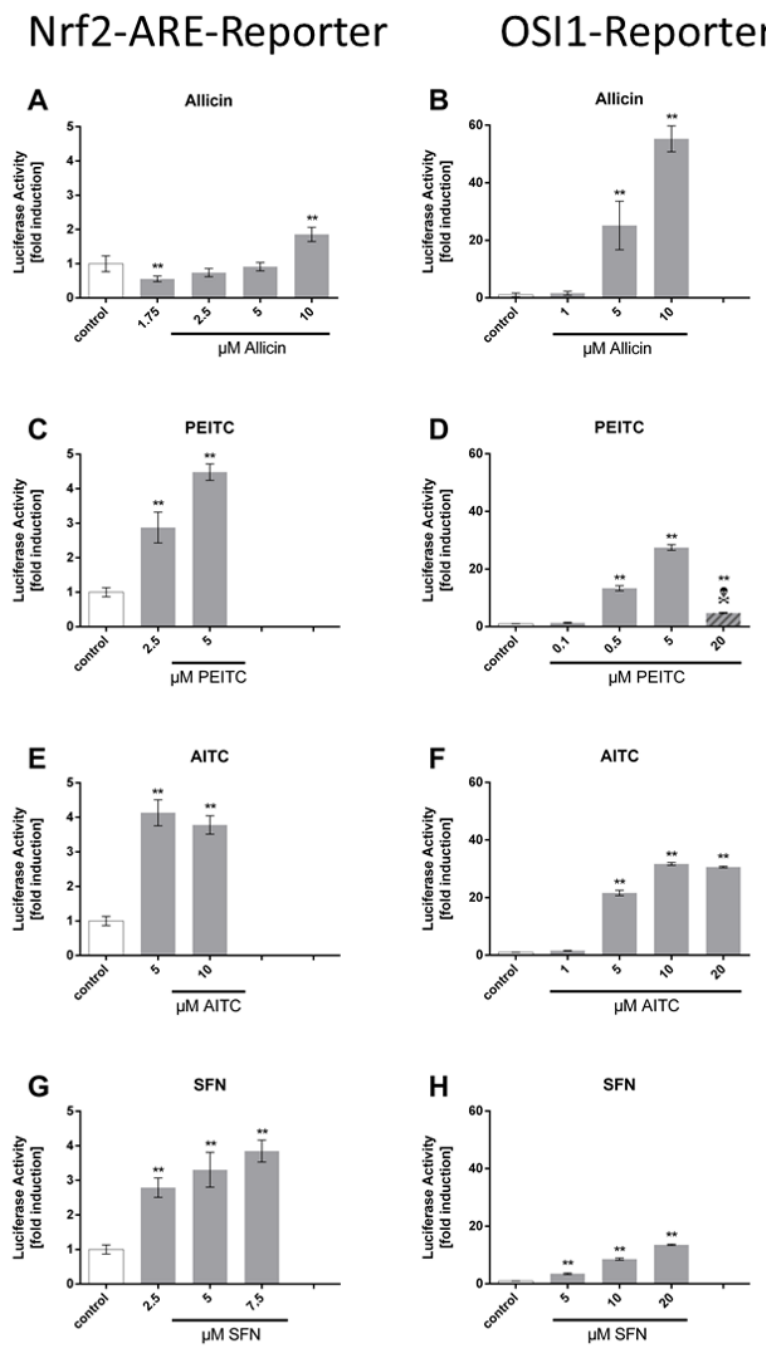
Figure 1. Responses of the antioxidant response element (ARE) and the OS-induced promoter of the YKL071w gene (OSI1) reporters to allicin, phenylethyl isothiocyanate (PEITC), allyl isothiocyanate (AITC), sulforaphane (SFN). ( A , C , E , G ) show the ARE assay with murine hepatocytes transfected with the SIN-lenti-ARE gene construct as reporter. Measurements were taken 6 h after treatment ( n = 8). ( B , D , F , H ) show the OSI1 assay with yeast cells transformed with the OSI1 promoter–luciferase gene construct as reporter ( n = 3). Measurements are shown after 1 h of co-cultivation with the respective test substance. Attention is drawn to the di ff erent y -axis scales of the ARE and OSI1 tests. Error bars show standard deviation. A normal distribution was assumed, and a one-way ANOVA was performed with Dunett’s multiple comparisons test for significance (** p < 0.01). RLU is the abbreviation for Relative Luminescence